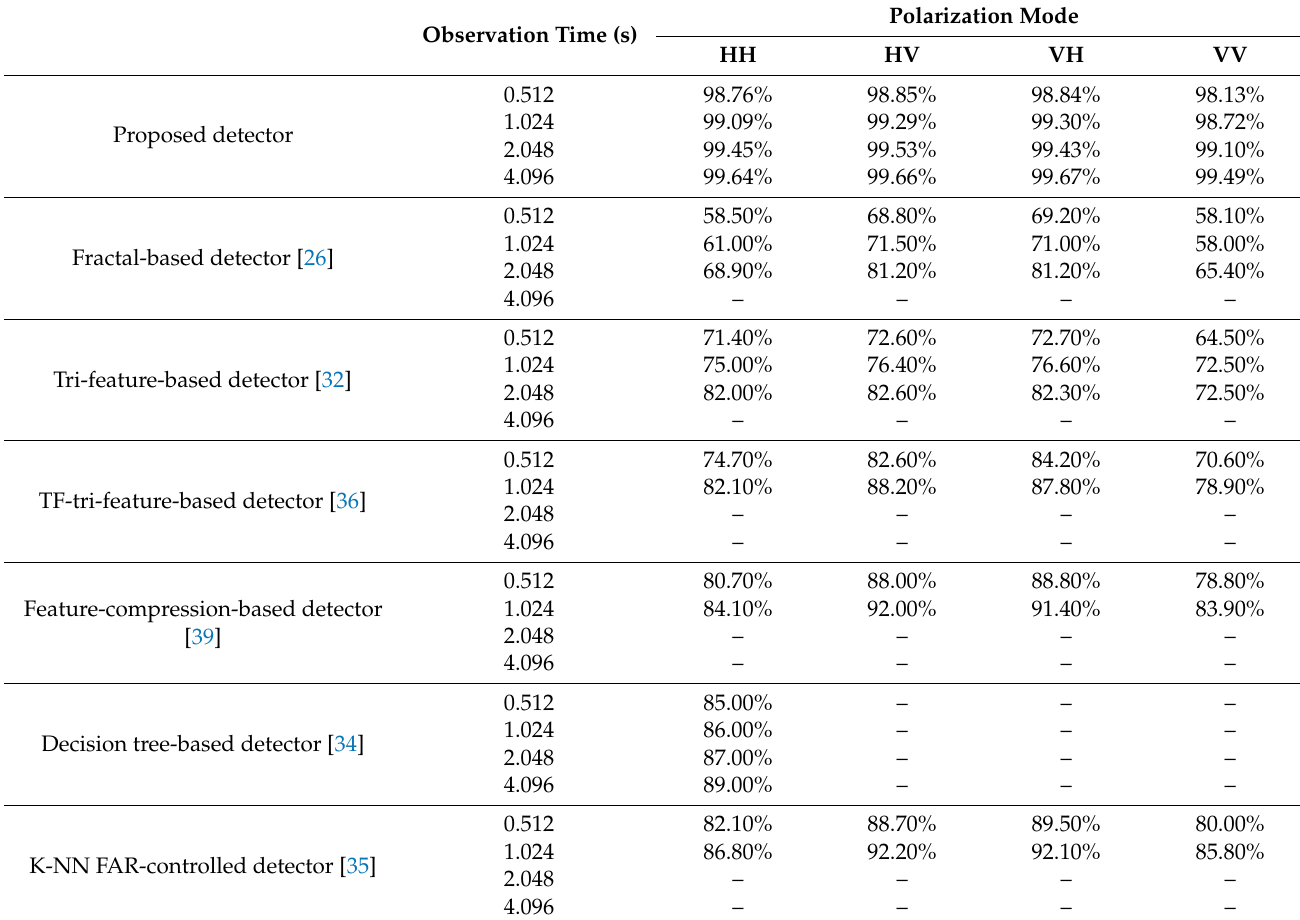
Table 14. Detection probability comparison in different